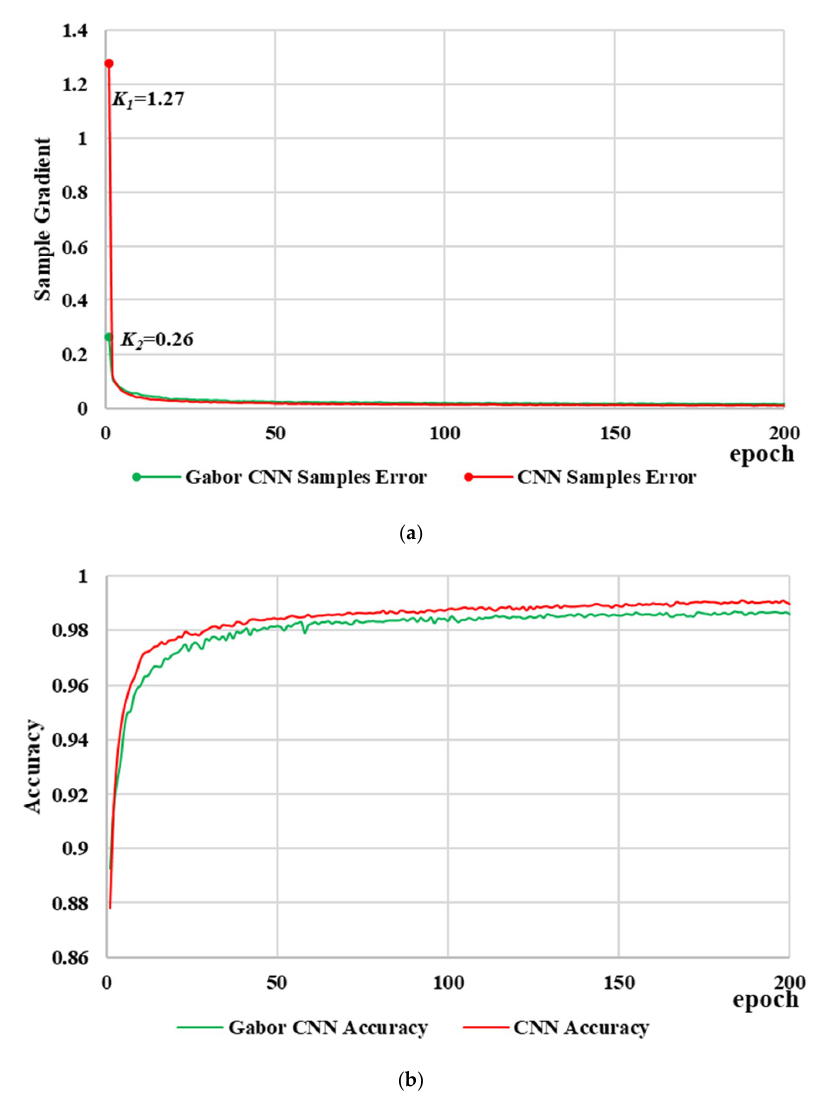
Figure 9. ( a ) Samples’ mean square error and ( b ) overall classification accuracy obtained from each structure.